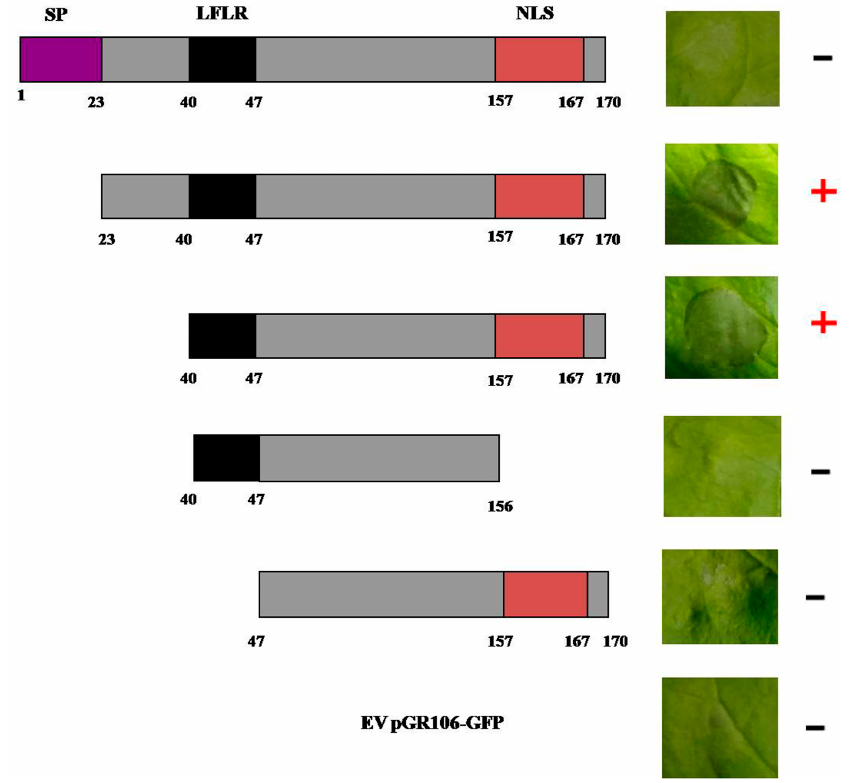
Figure 5. Deletion analysis of PITG_22798. Deletion mutants of PITG_22798 were transiently expressed in N. benthamiana by agroinfiltration. A schematic view of the different mutants and deletion constructs are shown on the left panel . Symptoms of infiltration sites are shown on the right panel . Plus (+) and minus ( − ) signs indicate the presence or absence, respectively, of cell death symptoms. The assays were repeated at least three times with similar results. Photograph of symptoms were taken at 6 dpi. SP, signal peptide. LFLR, an RxLR-like motif. NLS, nuclear localization signal sequence.